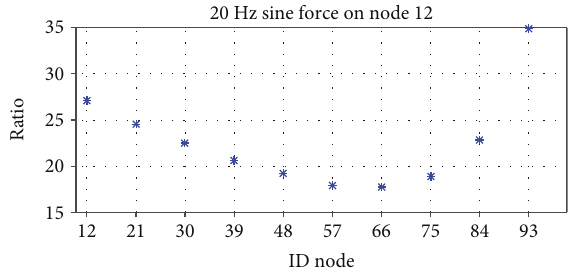
Figure 53: D2, 20 Hz sine excitation force in node 12, ratios between load levels.